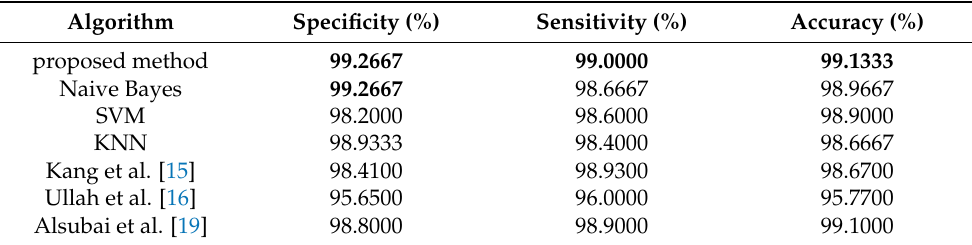
Table 5. Comparison of the proposed method with previous works in diagnosis of brain tumors in BTD20